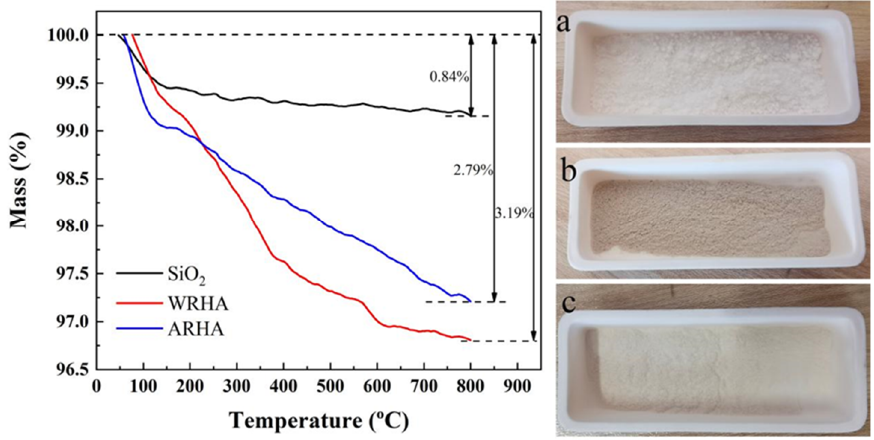
Figure 4. TGA curves in air flow and photographs (( a ) SiO 2 , ( b ) WRHA and ( c ) ARHA) of the three kinds of filler samples. kinds of filler